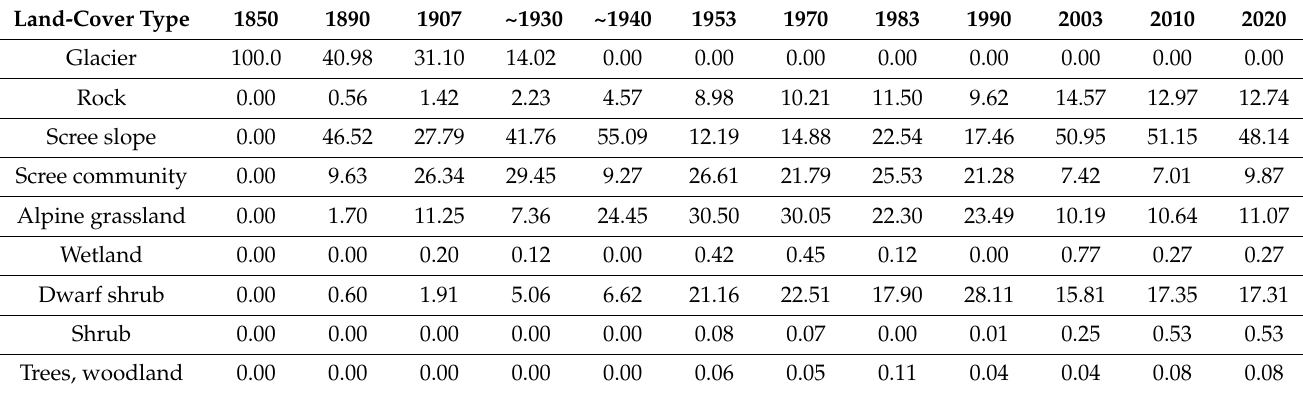
Table A7. Changes of land cover types from End of LIA to 2020 with the proportion of each land-cover type in the area of interest (AoI).